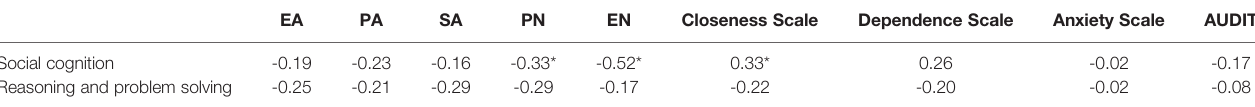
TABLE 3 | Correlations between childhood trauma and attachment styles and social cognition of patients with alcohol use disorders.